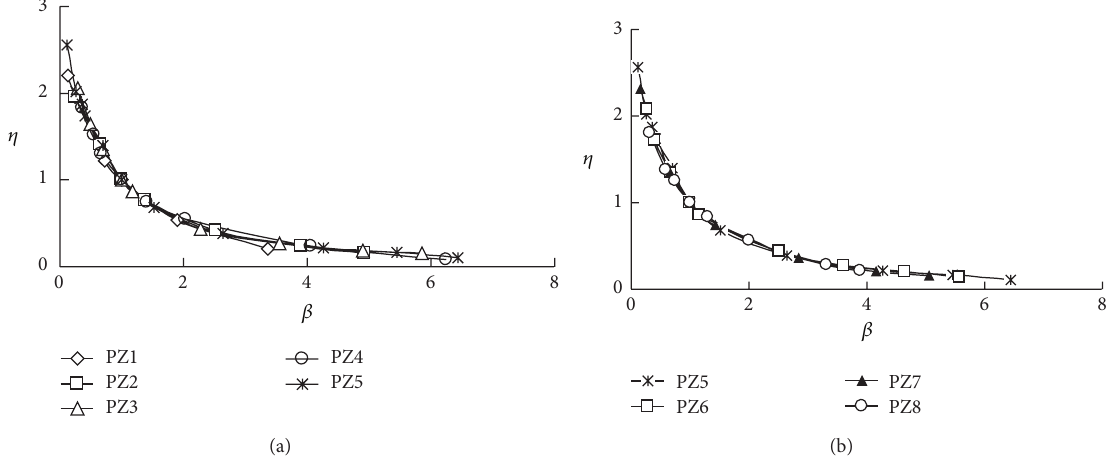
Figure 8: Relative stiffness degradation curves of specimens.